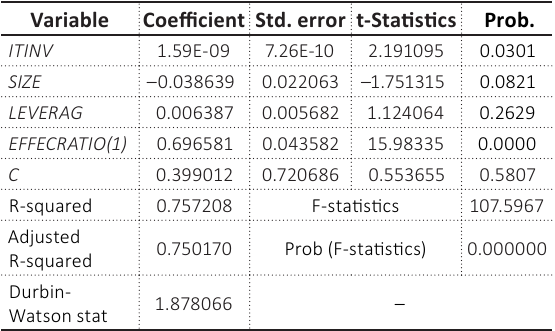
Table 7. Effect of IT investment on bank